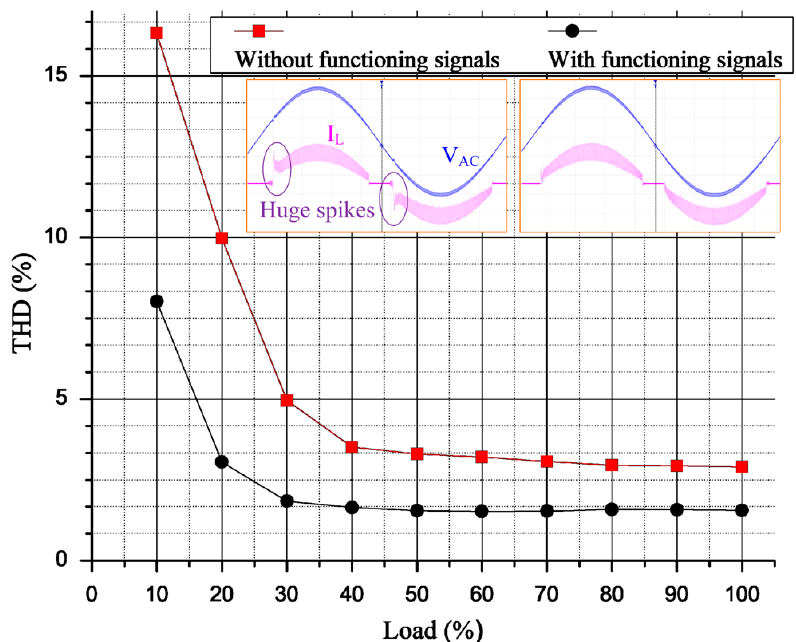
Figure 15. The measured harmonic distortion in the current (ITHD) and waveform comparisons with both the presence and absence of the functioning signals at the grid voltage zero-crossing zone over the full range of load.